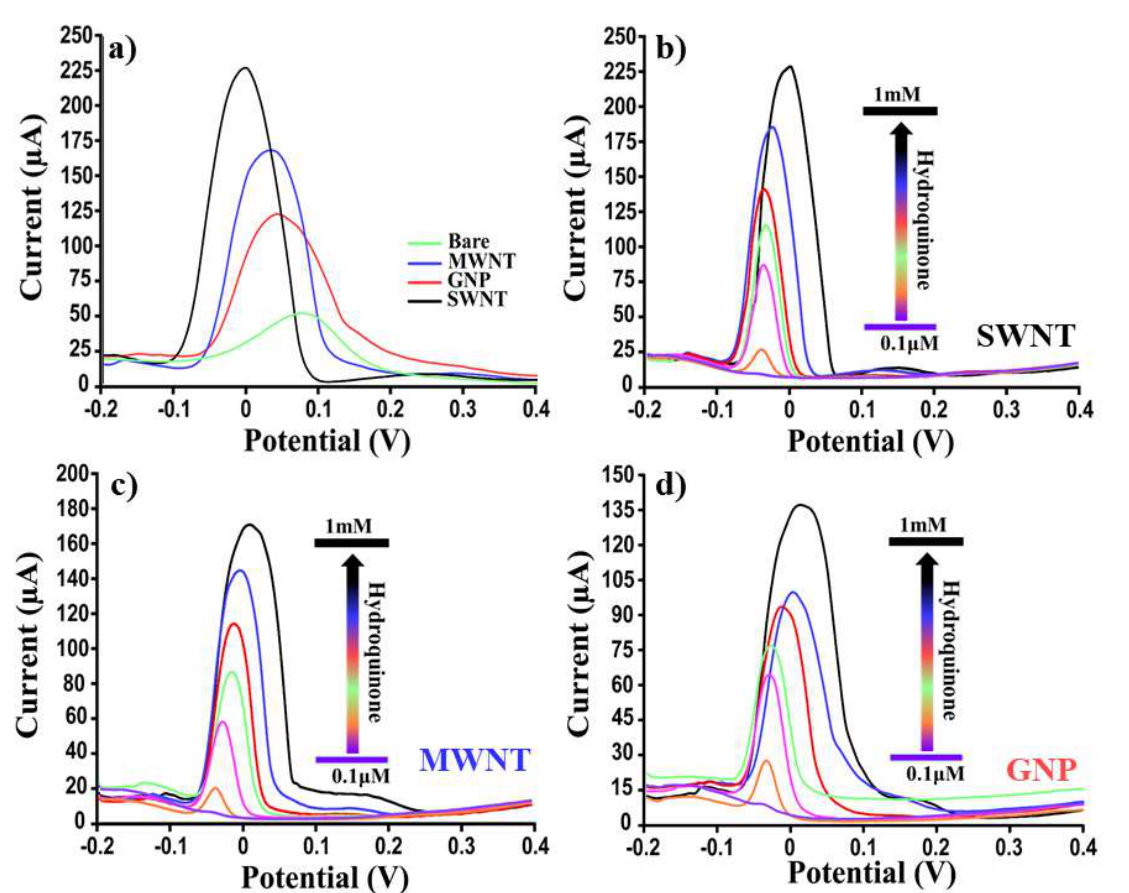
Figure 6. Dose–response voltammograms. Comparison of the SWVs for different platforms (SWNTs, MWNTs, GNPs, and bare SPEs) ( a ) at the same concentration of HQ (10 mM) and ( b – d ) at several HQ concentrations (from 0.1 to 1 mM). Curves of one representative CNM-modified SPE sensor of at least 6 analyzed platforms are presented. Table 2. Summary of the Limit of Detection (LOD) and reproducibility obtained using CV and SWV in the analyses of several concentrations of HQ and BQ in PBS solution. All analytical parameters are obtained from CV and SWV traces.